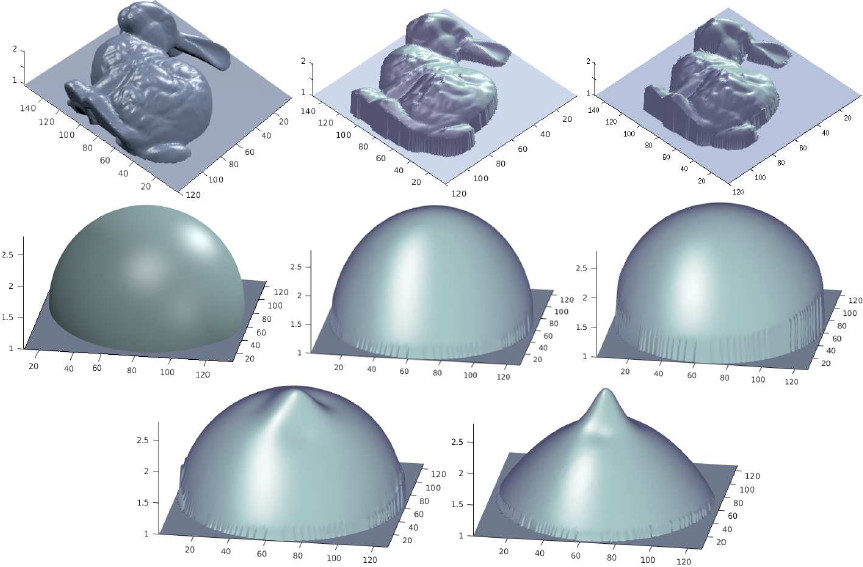
Fig. 11 Fisrt and second rows: left: ground truth; middle: depth reconstruction using complete Blinn–Phong model with PPN approach; right: depth reconstruction using Blinn–Phong model with PPS approach. The methods produce appealing reconstruction of images with strong specularities. The PPN approach provides more faithful reconstructions. Last row: depth reconstruction using a Lambertian model in the presence of specularity, with different perspective projection methods. Left: PPN approach; right: PPS approach. The Lambertian model is unable to provide a faithful reconstruction for specular